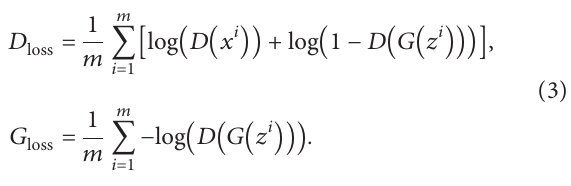
Training acc Validation acc Figure 7: Accuracy and loss after adding dropout and applying